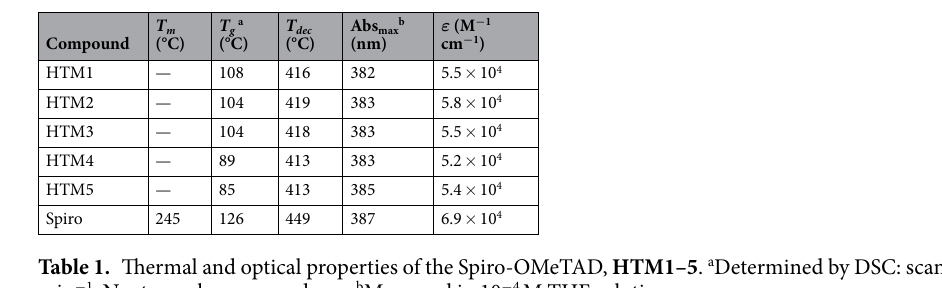
Table 1. Thermal and optical properties of the Spiro-OMeTAD, HTM1–5 . a Determined by DSC: scan rate, 10 K min − 1 ; N 2 atmosphere; second run. b Measured in 10 − 4 M THF